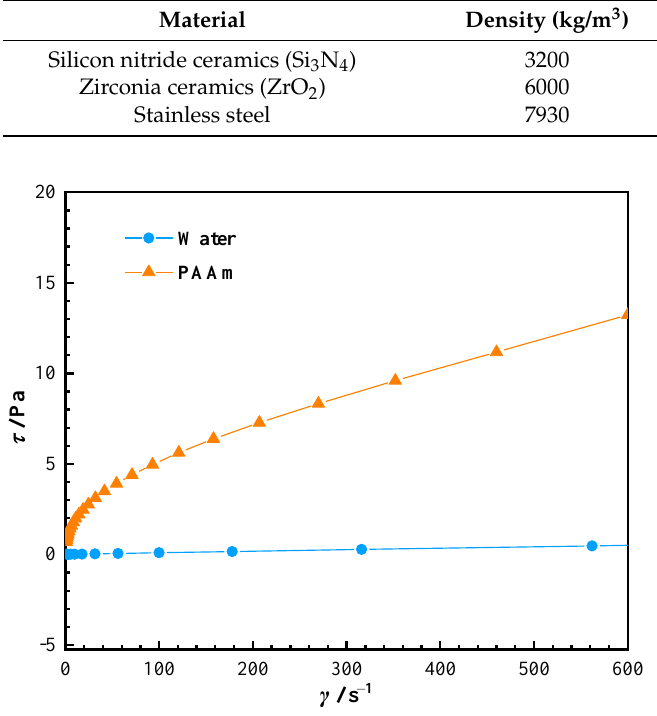
Figure 2. Schematic of the PIV system for investigating the flow field of the wake behind the particle. Table 1. Properties of spherical particles.